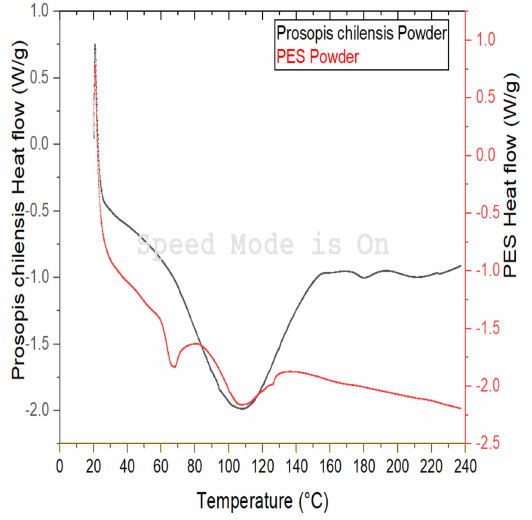
Figure 6. DSC curve of the PES and PCP powders between 20 ◦ C and 240 ◦ C at a heating rate of 10 ◦ C /